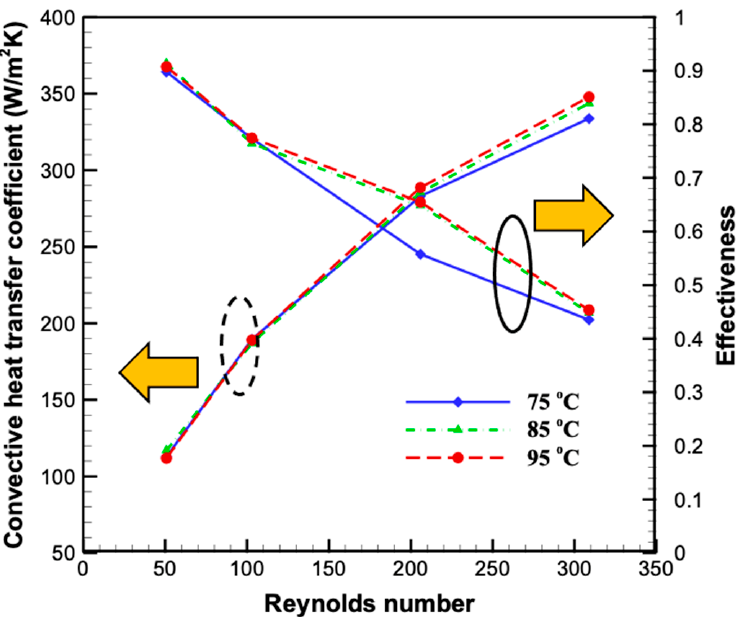
Figure 7. Convective heat transfer coefficient and effectiveness versus Reynolds number for different hot inlet temperatures.